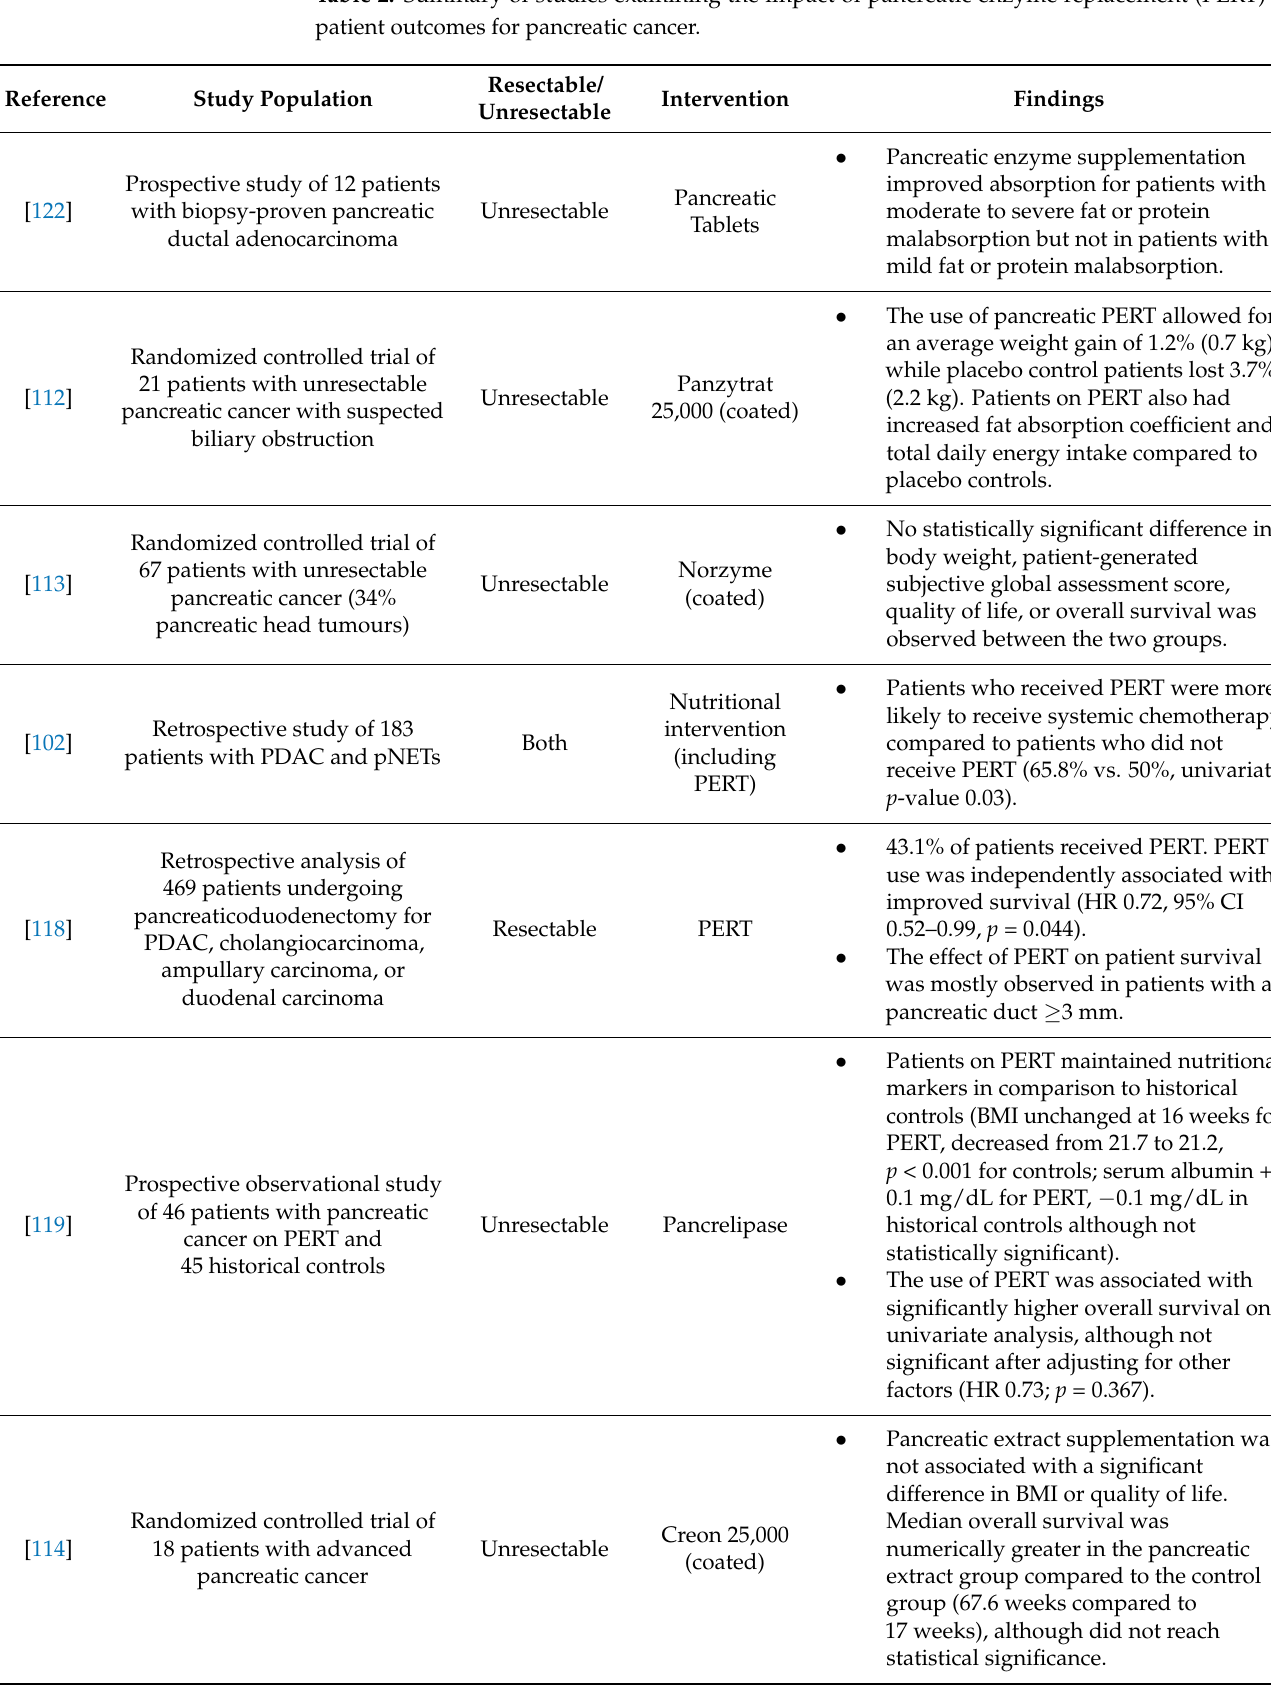
Table 2. Summary of studies examining the impact of pancreatic enzyme replacement (PERT) on patient outcomes for pancreatic